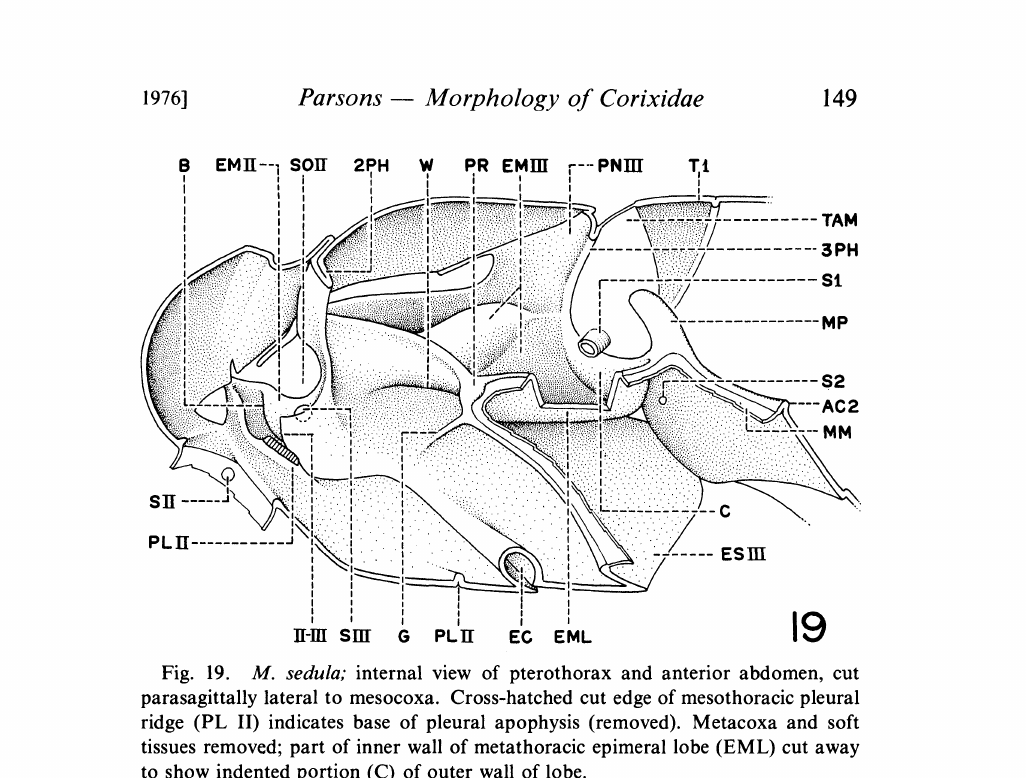
Fig. 19. M. sedula; internal view of pterothorax and anterior abdomen, cut parasagittally lateral to mesocoxa. Cross-hatched cut edge of mesothoracic pleural ridge (PL II) indicates base of pleural apophysis (removed). Metacoxa and soft tissues removed; part of inner wall of metathoracic epimeral lobe (EML) cut away to show indented portion (C) of outer wall of